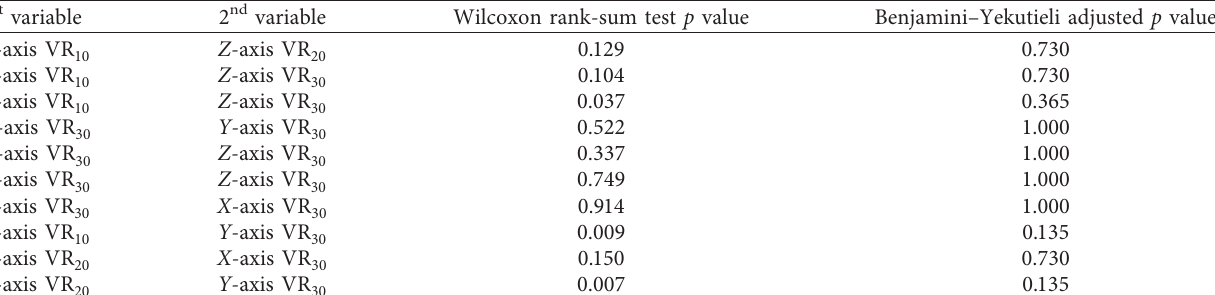
Table 6: Significant tests of difference among VR